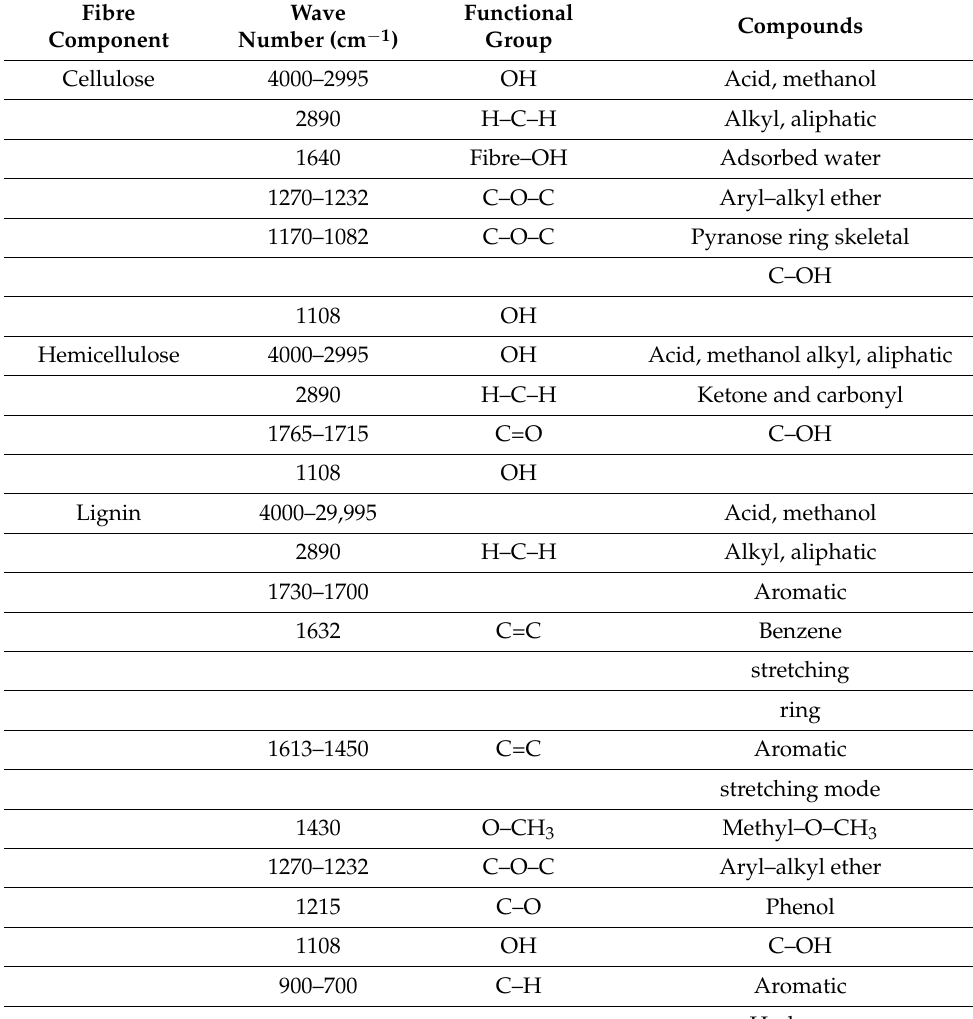
Table 2. The FT-IR bands for functional groups of cellulose, hemicellulose and